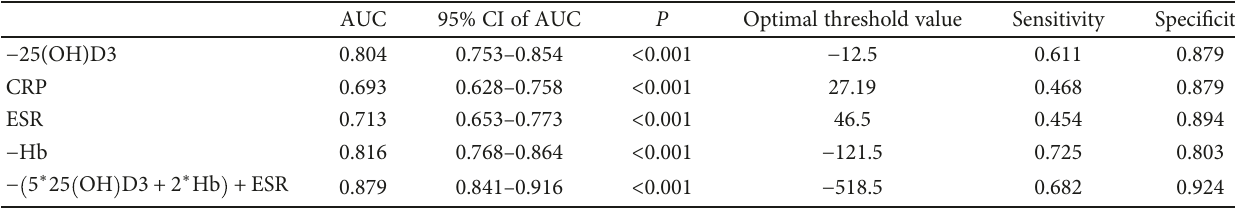
Table 4: Receiver-operating characteristic analysis for active disease.